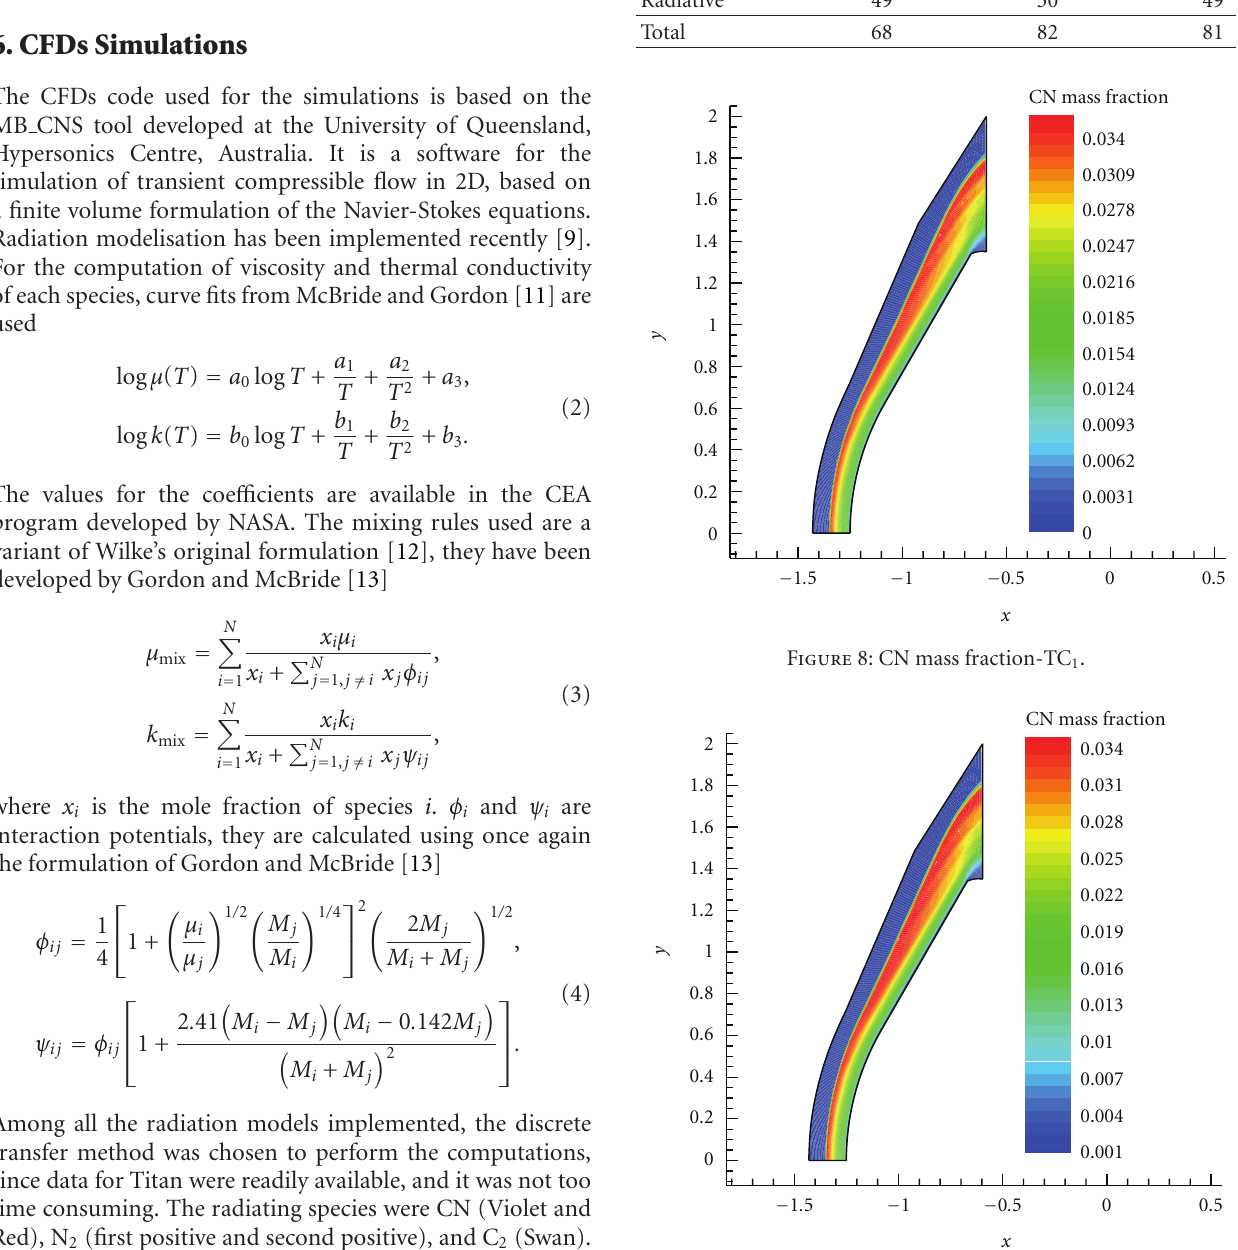
Figure 9: CN mass fraction-TC 3